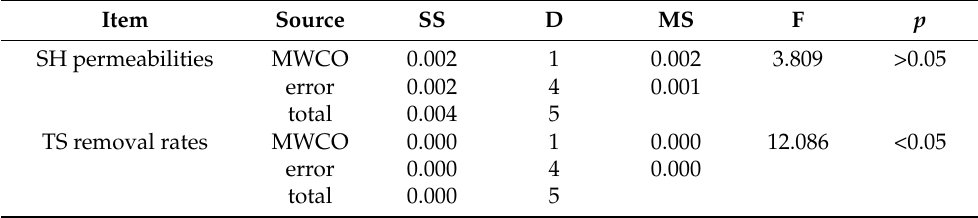
Table 6. ANOVA results of SH permeabilities and TS removal rates.